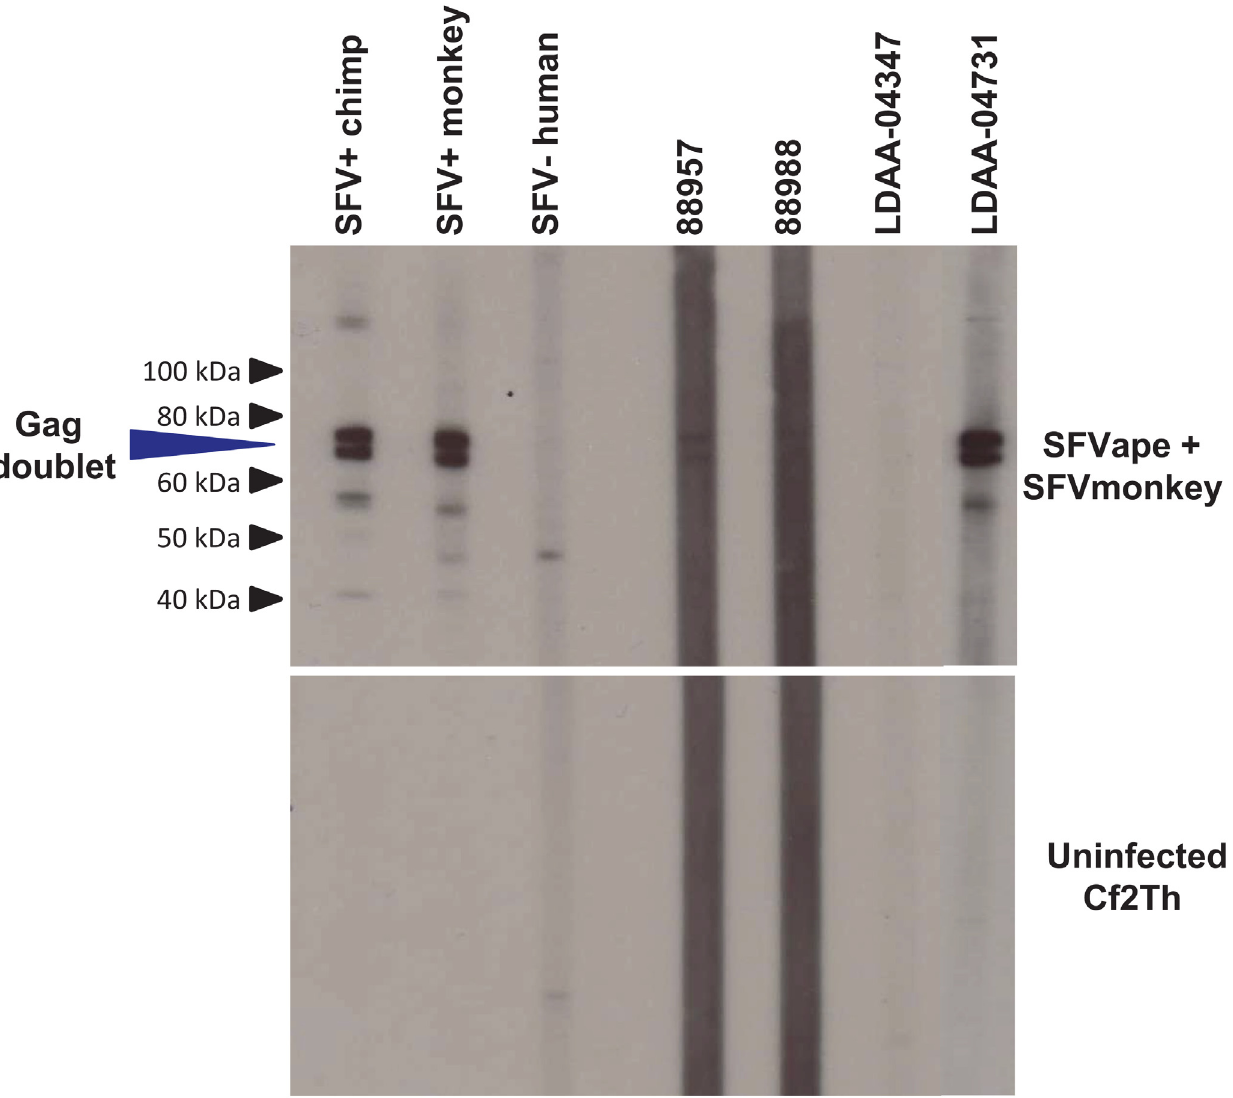
Fig 1. Western blot detection of antibodies to simian foamy virus (SFV) in persons from Côte d ’ Ivoire, 1985 – 1996. Upper panel shows seroreactivity of representative patient samples to the combined SFV antigens from ape (chimpanzee) and African green monkey infected cell cultures. Lower panel shows reactivity to crude cell lysate antigens from uninfected canine thymocytes (Cf2Th). Seroreactivity was defined for those specimens with reactivity specific to the diagnostic Gag doublet proteins (p72/p74) in the combined antigen assay. Patient LDAA-04731 is co-infected with